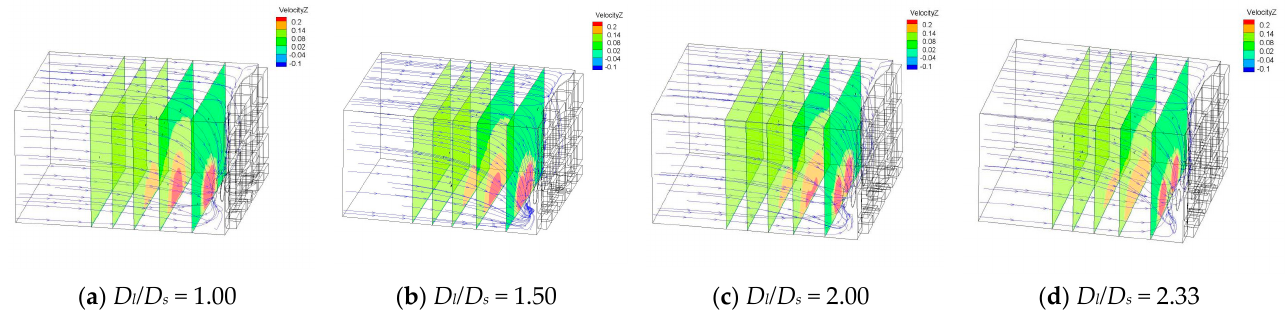
Figure 21. Suction sump of different sections of axial flow velocity distribution cloud (sections 2-1~2-5, unit: m/s).